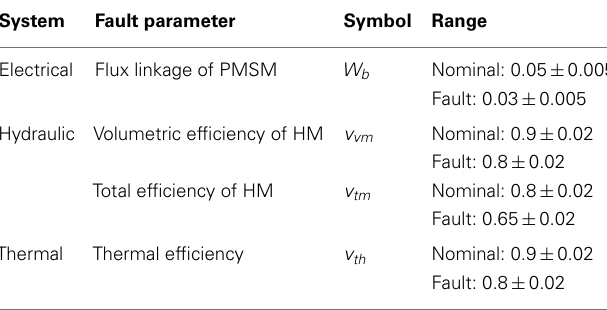
Table 2 | Fault parameters of the system